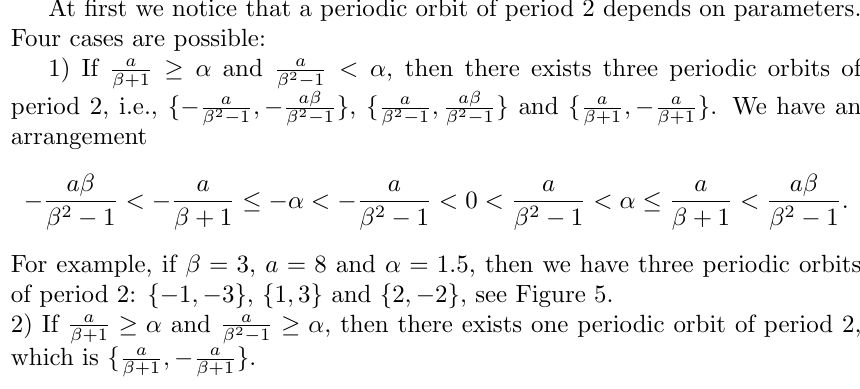
Figure 5. If β = 3, a = 8 and α = 1 . 5, then we have three periodic orbits of period 2: {− 1 , − 3 } , { 1 , 3 } and { 2 , − 2 } . At first we notice that a periodic orbit of period 2 depends on